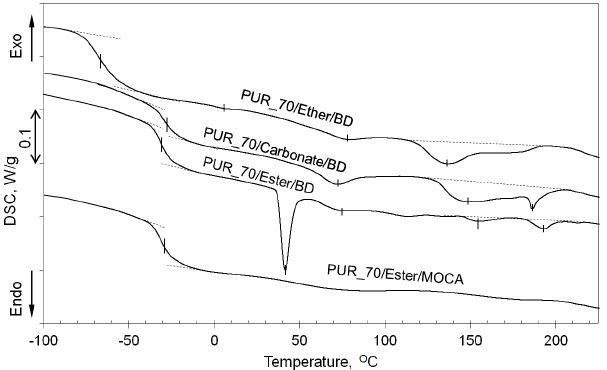
Figure 10. DSC curves of PUR with various chemical composition. Contents of the soft segment for all materials is constant (SS = 70%). First heating.